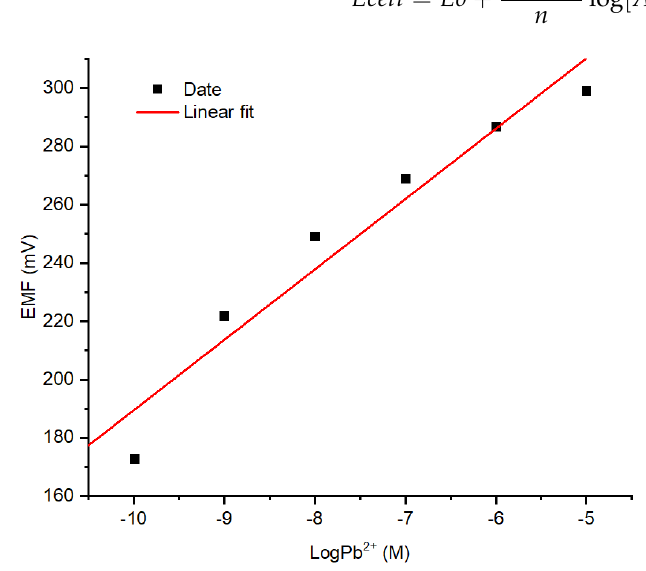
Figure 7. Response profile of Pb 2+ ISE on varied concentrations of Pb(NO 3 ) 2.